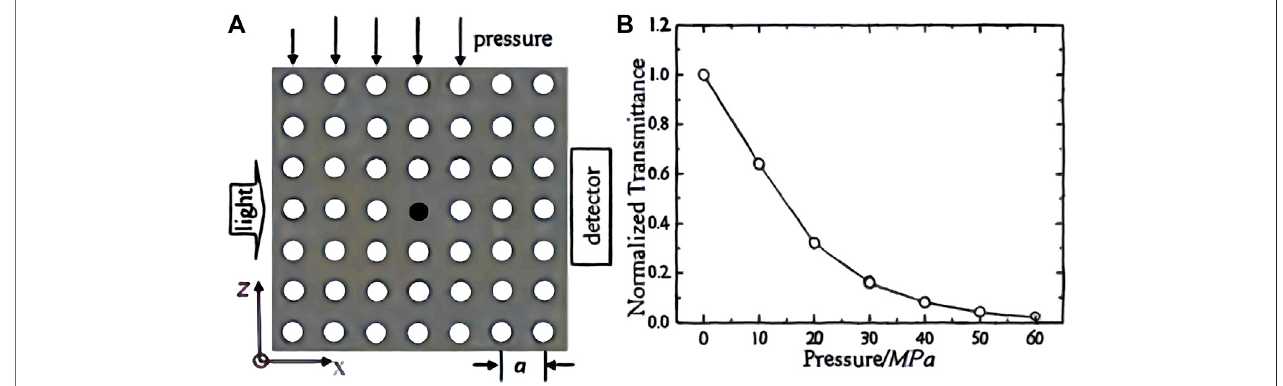
FIGURE11|(A) Schematic ofa2D-PCsensorformed bypolymerizingaPNIPAAm hydrogelontoasingle-layer microspherearray.ThePNIPAAm hydrogelswells after binding to the surfactant molecule, and the ball spacing increases, resulting in diffraction red-shift; (B) The normalized diffraction spectrum of the 2D-PC PNIPAAm sensor in aqueous solution of sodium dodecylsulfonate (SDS) at different concentrations; (C) The diffraction wavelength to the SDS concentration response and corresponding color change (Zhang et al., 2012).